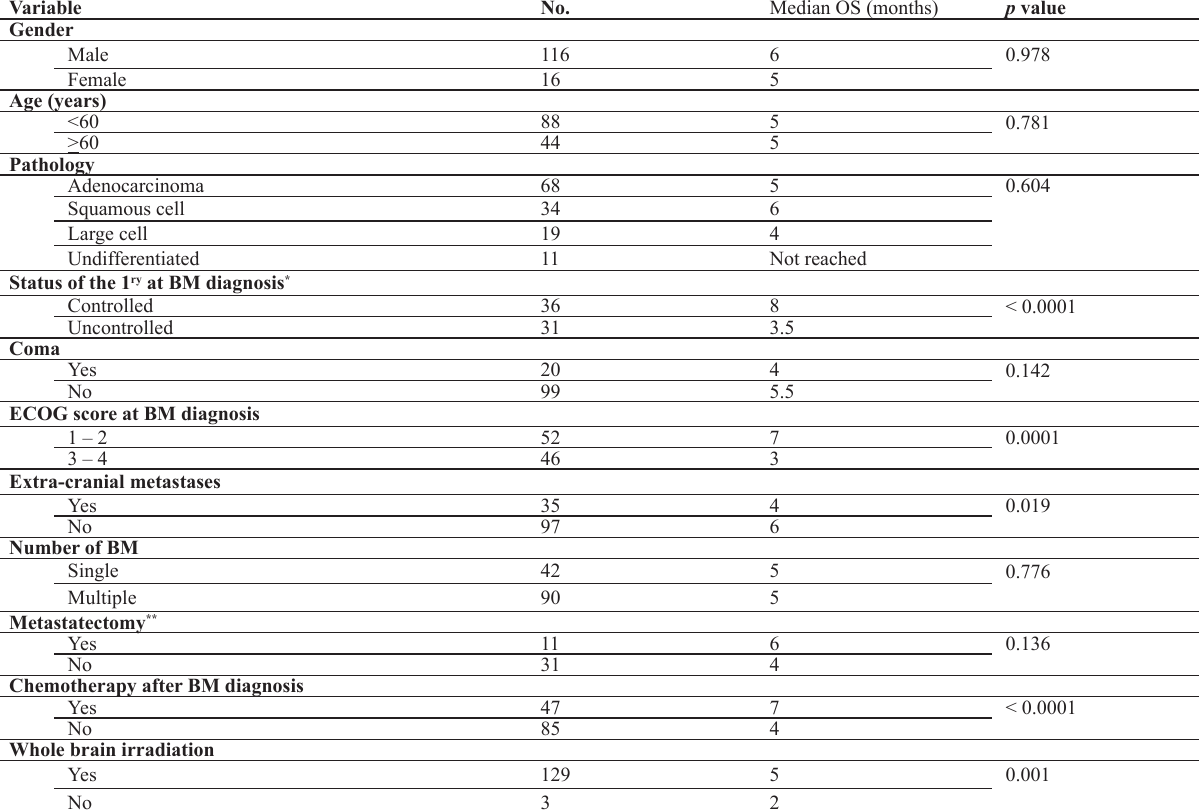
table 4: Analysis of factors affecting overall survival (OS) after development of brain metastases (BM)